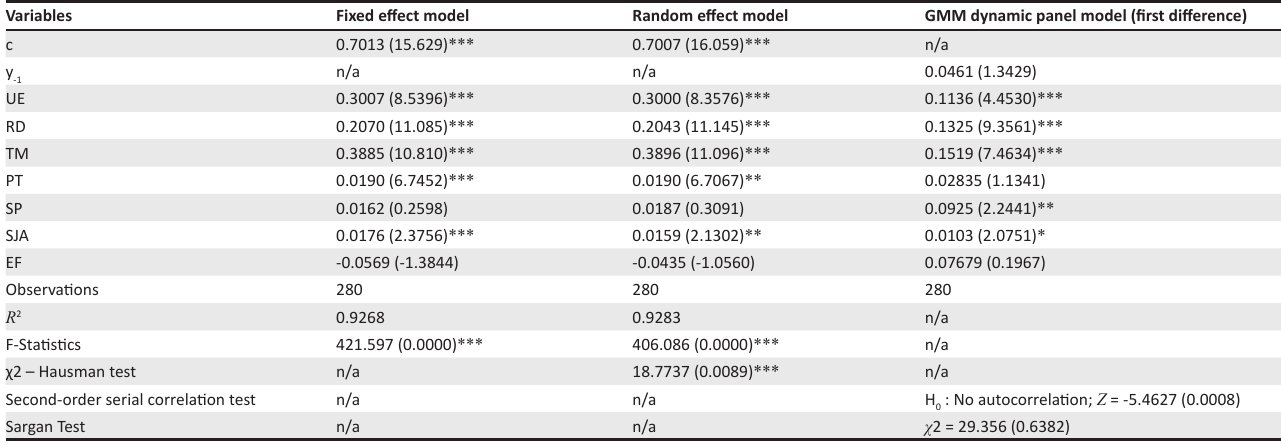
TABLE 3: Panel estimation results. Variables Fixed effect